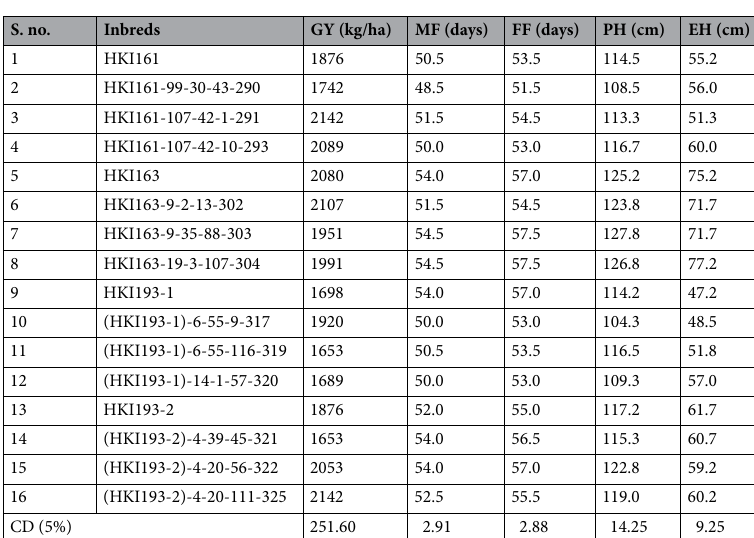
Table 5. Morphological characterization of introgressed progenies and their respective recurrent. GY Grain yield, MF days to anthesis, FF days to silking, PH plant height, EH ear height, CD Critical difference